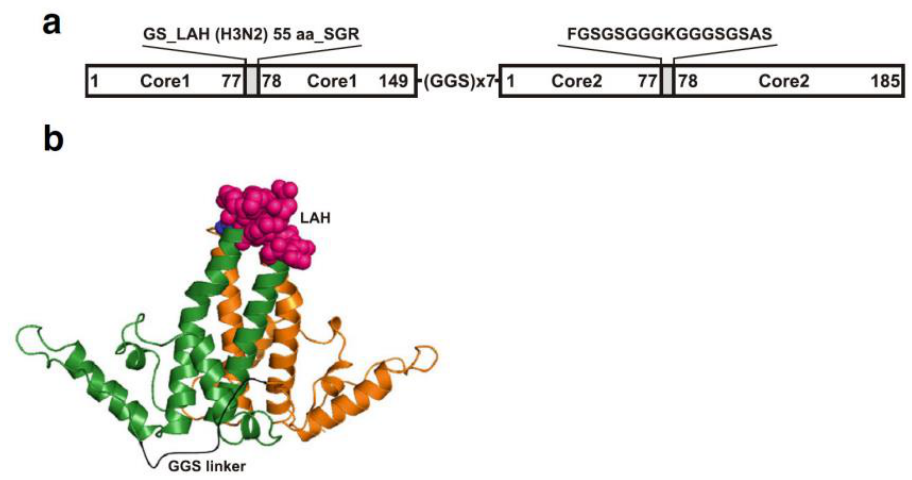
Figure 4. An example of expression of influenza epitope using chimeric VLP based on recombinant LAH3-HBc gene. Design ( a ) and cartoon ( b ) of the LAH3-HBc dimer. Individual hepatitis B virus core protein (HBc) monomers are shown in green and orange. The first major immunodominant region (MIR) contains the LAH domain (the 55 amino acid long influenza H3N2 virus (A / Hong Kong / 1 / 1968, Accession No. AAK51718) HA stalk domain, corresponding to HA amino acids 420–474, shown as pink spheres) while the second MIR contains lysine linker (blue spheres)). The model was created using PyMOL version 1.7rc1. The tandem core dimer is based on the structure from PDB-1QGT, with the linker shown in black.